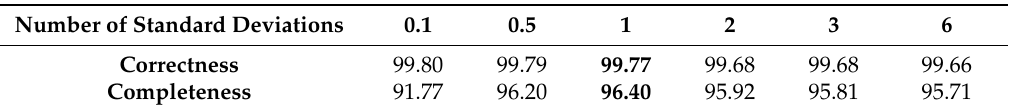
Table 8. Completeness and correctness percentages for different values of the number of standard deviations as a limit for exclusion of nodes in Smoothing